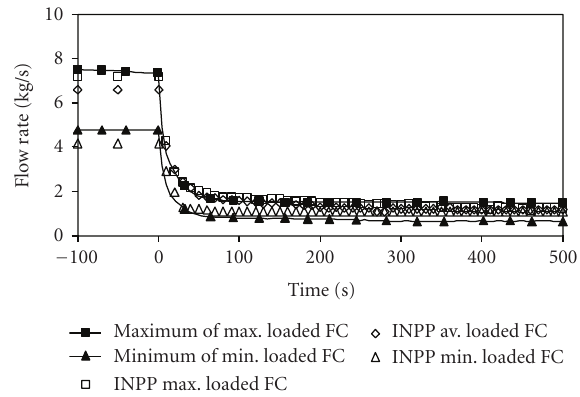
Figure 2: Loss-of-all-MCPs event. Coolant flow rate through indi- vidual channels.